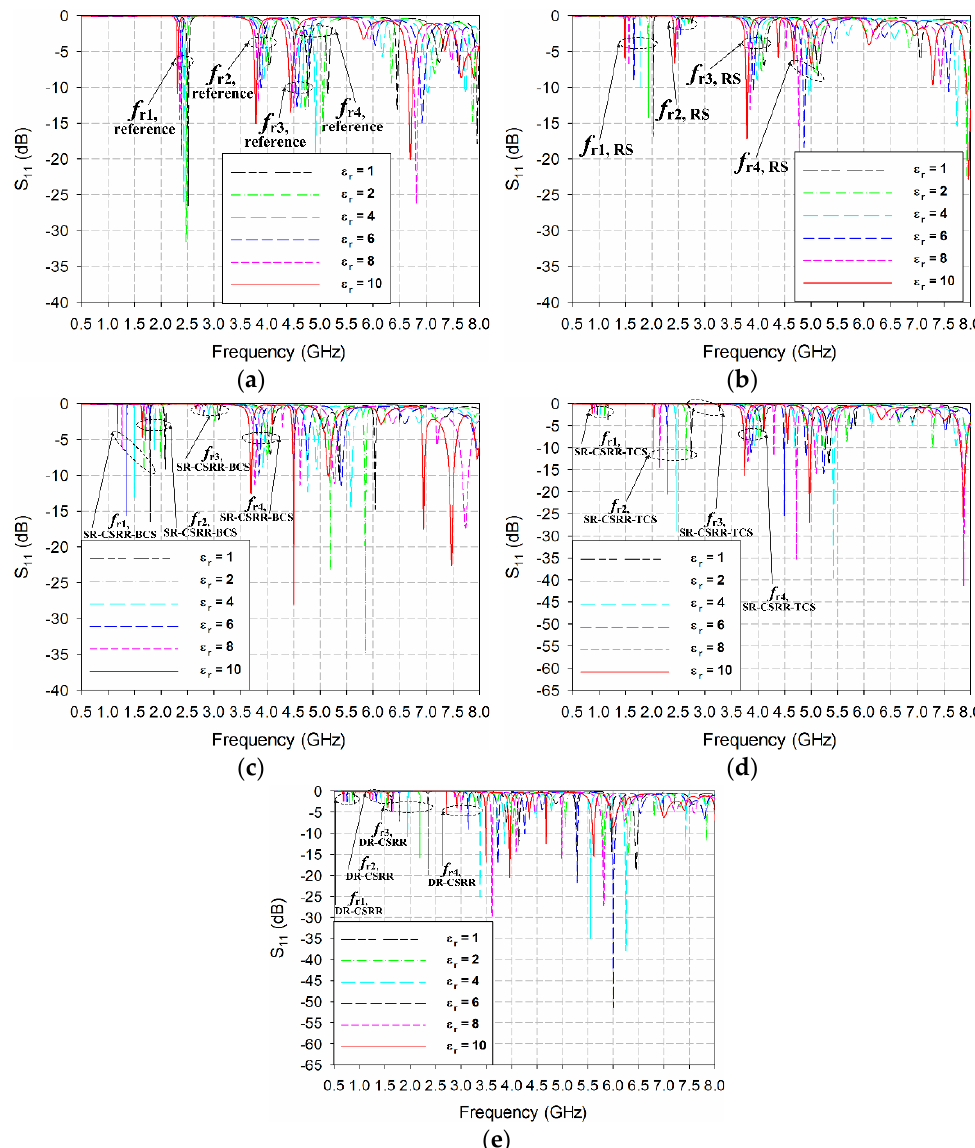
Figure 5. Input reflection coefficient responses of the reference and four slot ‐ loaded MPAs for varying the relative permittivity of the MUT superstrate from 1 to 10: ( a ) the reference rectangular MPA, ( b ) the RS ‐ loaded MPA, ( c ) the SR ‐ CSRR ‐ BCS slot ‐ loaded MPA, ( d ) the SR ‐ CSRR ‐ TCS slot ‐ loaded MPA, and ( e ) the DR ‐ CSRR slot ‐ loaded MPA.